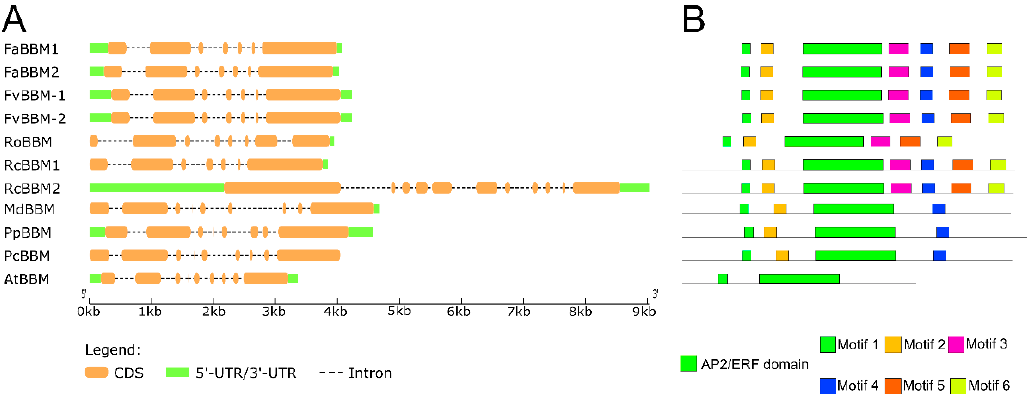
Figure 3. BBM gene and protein structures in Rosaceae species and Arabidopsis thaliana . ( A ) Exon–intron structure of BBM genes. ( B ) AP2/ERF domain and motifs in BBM proteins. ( C ) Multiple alignments of BBM proteins. BBM : BABYBOOM ; Fa: Fragaria × ananassa ; Fv: Fragaria vesca ; Ro: Rubus occidentalis ; Rc: Rosa chinensis ; Md: Malus × domestica ; Pp: Prunus persica ; Pc: Pyrus communis; At: Arabidopsis thaliana. A list of accession numbers for protein sequences is available in Table S3.